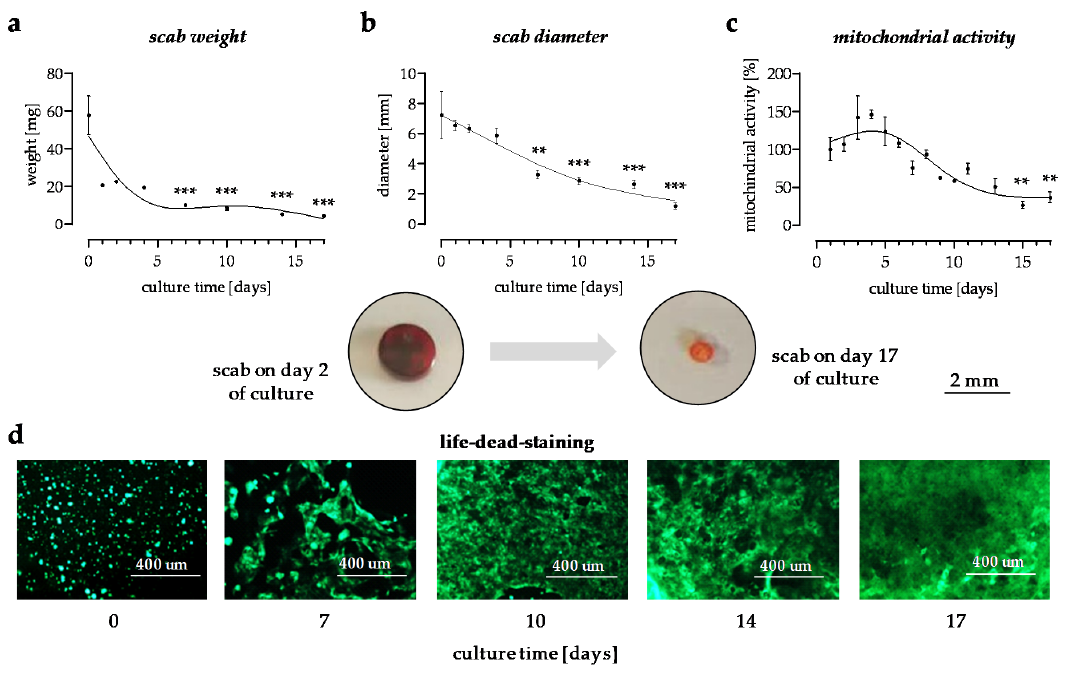
Figure 1. The in vitro scab model can be maintained in culture for more than 14 days. ( a ) The weight of the in vitro scabs in mg N = 4, n ≥ 5. ( b ) scab diameter in mm. N = 4, n ≥ 3. ( c ) Change in mitochondrial activity shown as fold of day 0. N = 3, n = 3. ( d ) Viability staining. Representative images were taken at a 10-fold magnification. Images were taken on days 0, 7, 10, 14, and 17 of culture. ** p < 0.01 and *** p < 0.001 as compared to day 0.